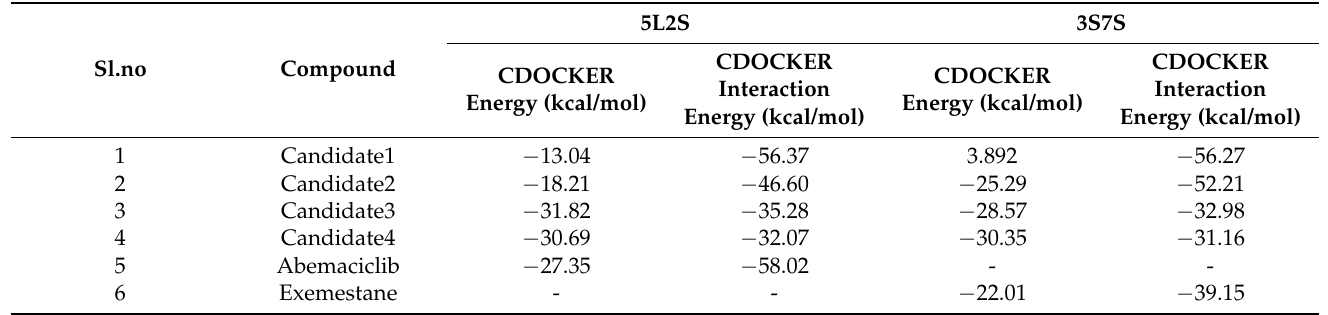
Table 3. Molecular docking result of identified candidates docked to target CDK6 and aromatase